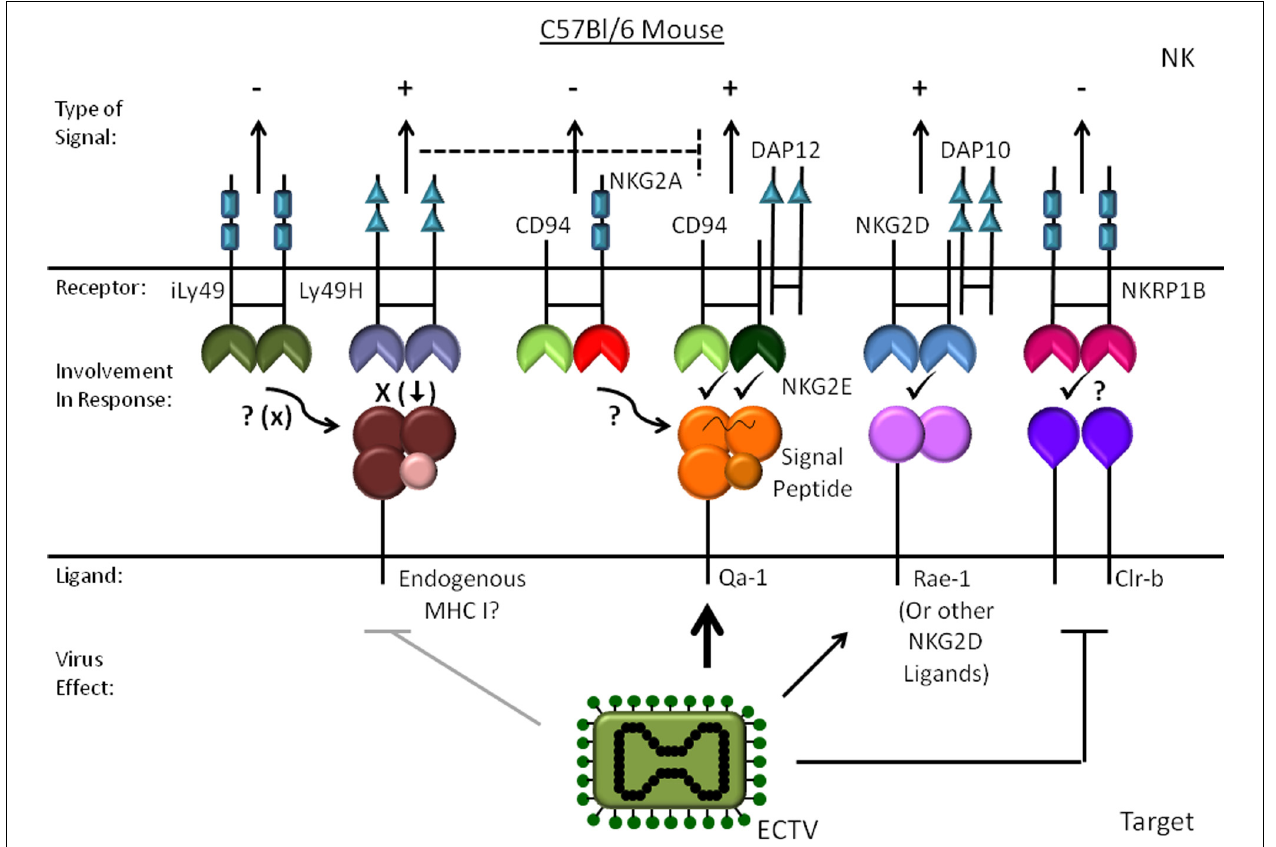
FIGURE 2 | Mouse NK cell recognition of ectromelia virus-infected cells. The activating and inhibitory mouse receptors and ligands are shown for ectromelia virus infection.The effect of infection on the ligands is indicated with an arrow for molecules that increase and a line to proteins that are